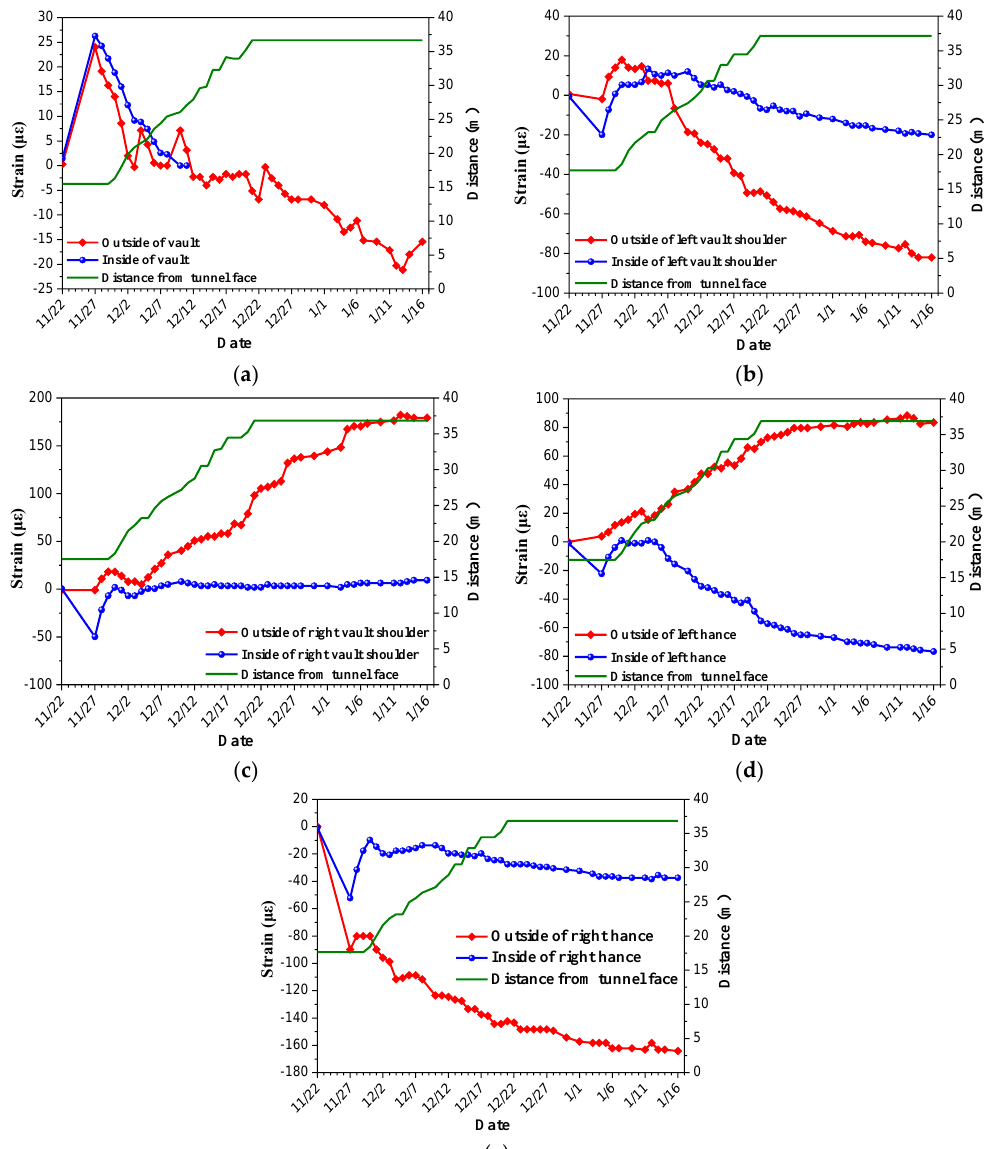
Figure 9. Monitoring results of second lining strain in Section 3: ( a ) vault; ( b ) left vault shoulder; ( c ) right vault shoulder; ( d ) left hance; ( e ) right hance.